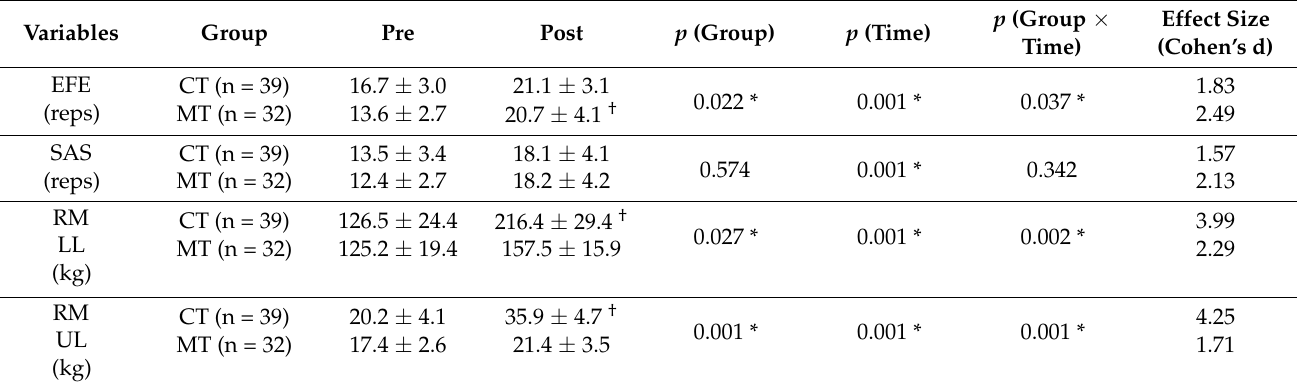
Table 2. Mean ± standard deviation of the tests used to assess pre- and post-intervention physical